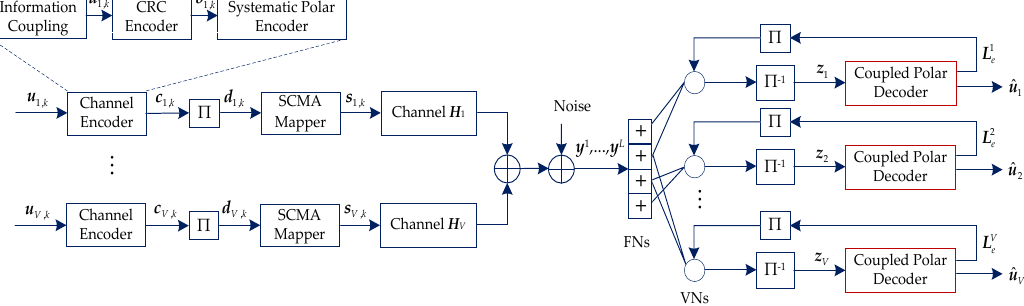
Figure 1. Uplink information-coupled polar-coded sparse code multiple access (PC-SCMA) system.